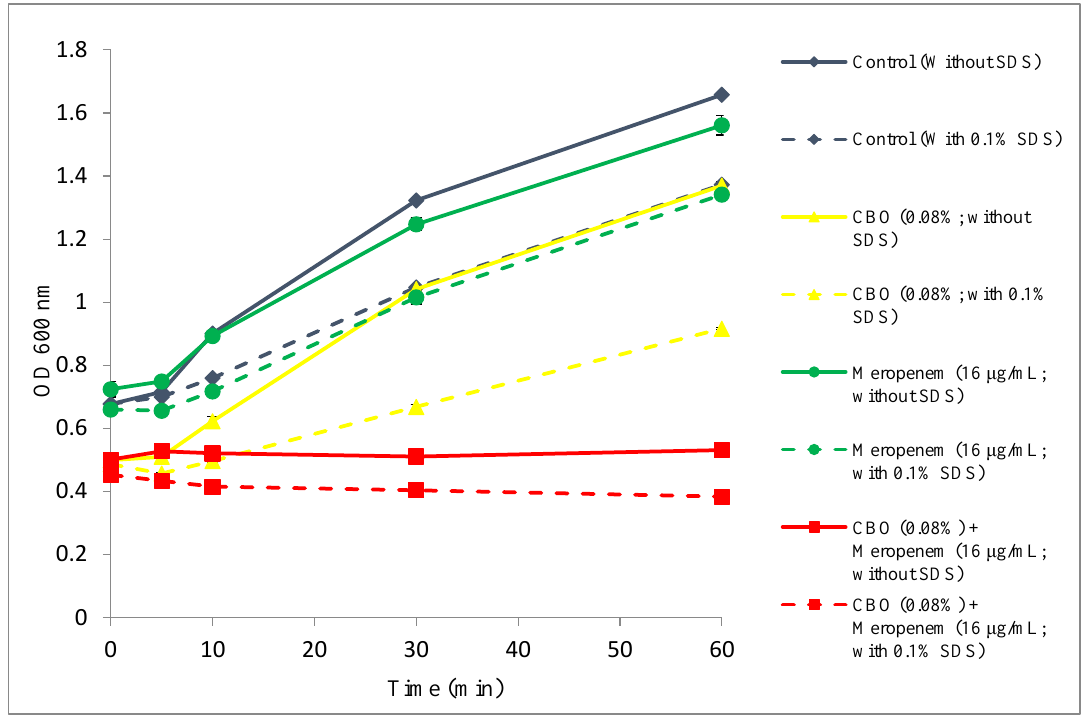
Figure 4. Comparative absorbance of treated K. pneumoniae BAA-1705 subjected to 0.85% saline solution and 0.1% SDS influx.